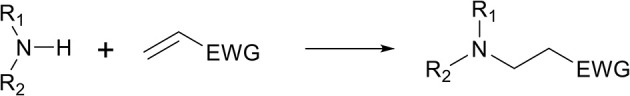
Generalized reaction scheme of the aza-Michael addition reaction between a primary (R1 = H, R2 ≠ H), or a secondary amine (R1, R2 ≠ H), and an electron deficient alkene with an electron withdrawing group (EWG).